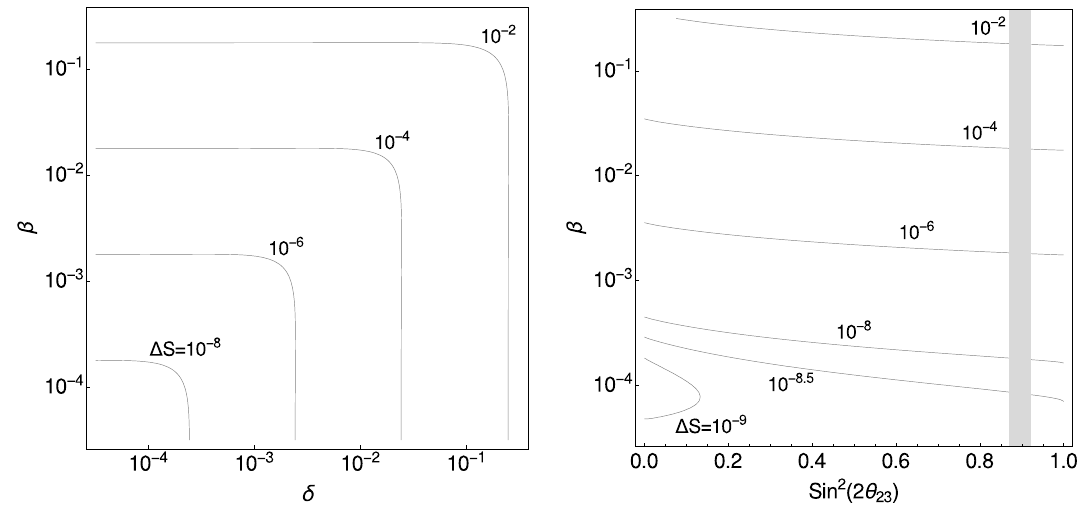
Figure 4. Family entropy increase for a system of three mixed neutrino states as functions of the initial spectral distortions δ and β (left). The values for the mixing angles are taken from the global fit to neutrino-oscillation data [40], assuming a normal neutrino hierarchy and a vanishing Dirac CP-violation phase. In the right panel the distortion δ is set to 10 − 4 and the mildly constrained mixing angle θ 23 is allowed to vary (shaded area is the allowed 3 σ